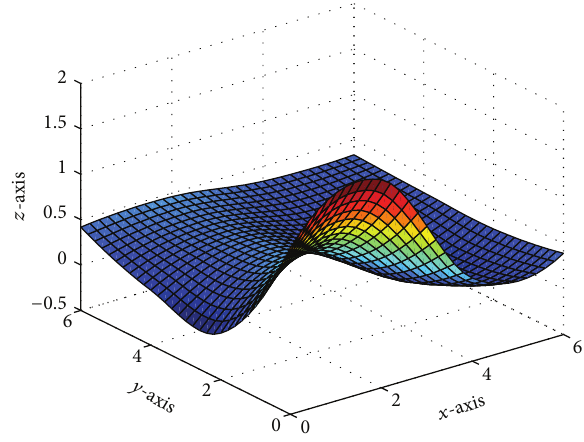
Figure 2: Bicubic Hermite surface.